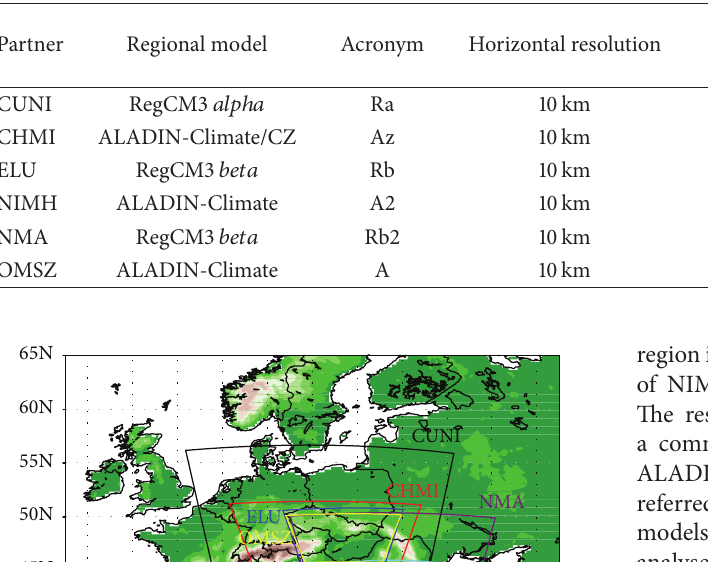
Table 1: CECILIA RCM-GCM setup.